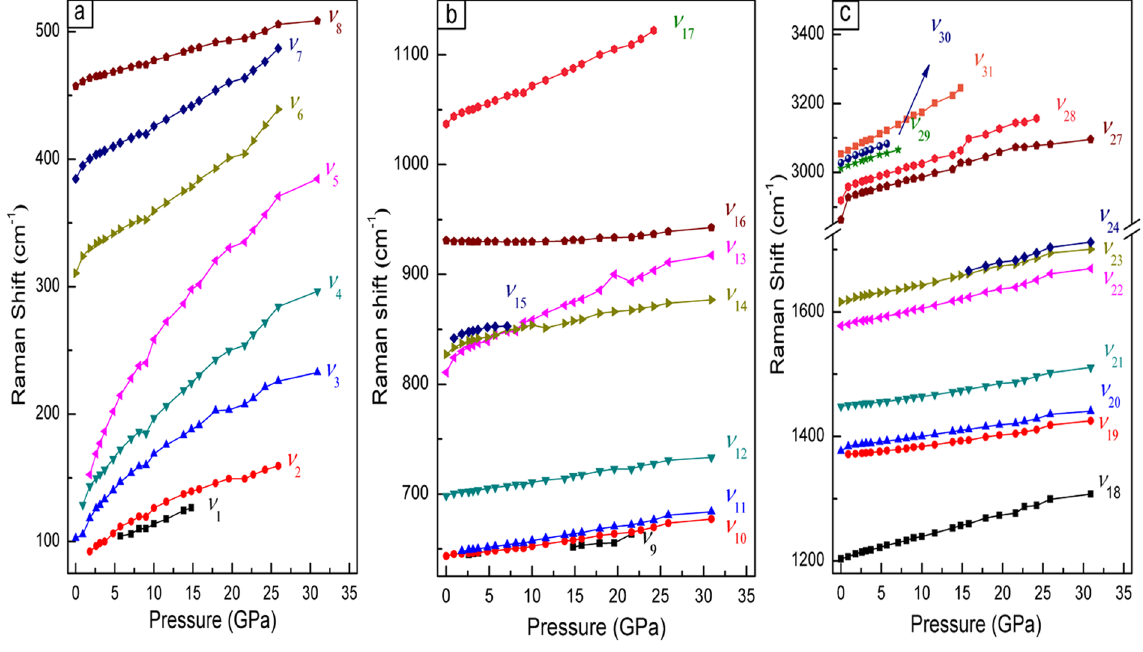
Figure 7. Pressure-dependence of the vibrational modes. Regions: ( a ) 75–525 cm − 1 ; ( b ) 625–1150 cm − 1 ; and ( c ) 1195–3500 cm − 1